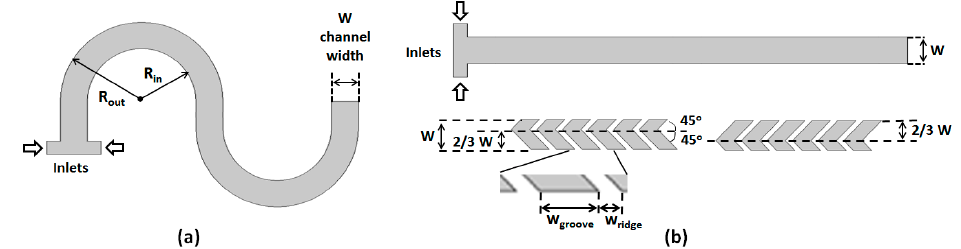
Figure 2. ( a ) Top view of the curved channel; ( b ) ( top ) Top view of the SHB channel; and ( bottom ) configuration of the asymmetric grooves placed on the bottom of the channel.